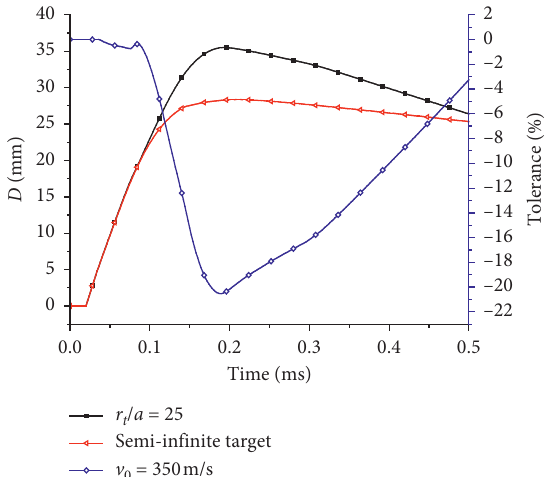
Figure 20: Deviation comparison of the penetration depth for the free boundary ( r t / a � 25) and the nonreflecting boundary ( v � 350m/s).